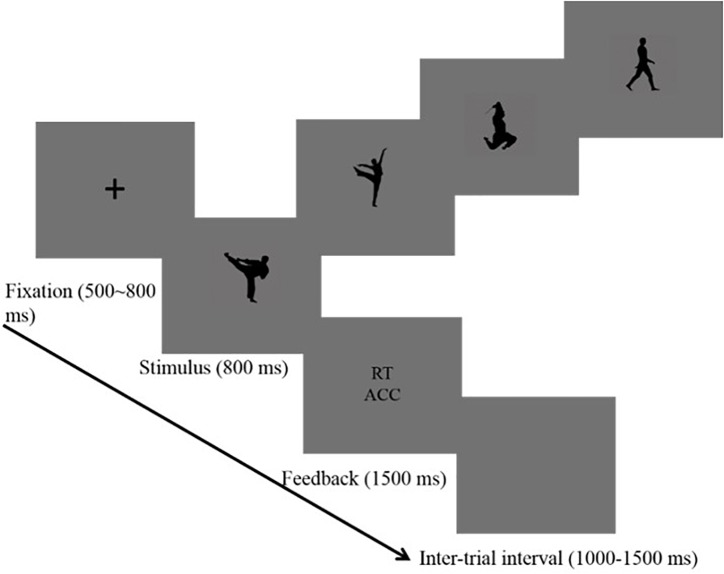
Procedure used in the categorization task that shows the sequence of events within a trial.